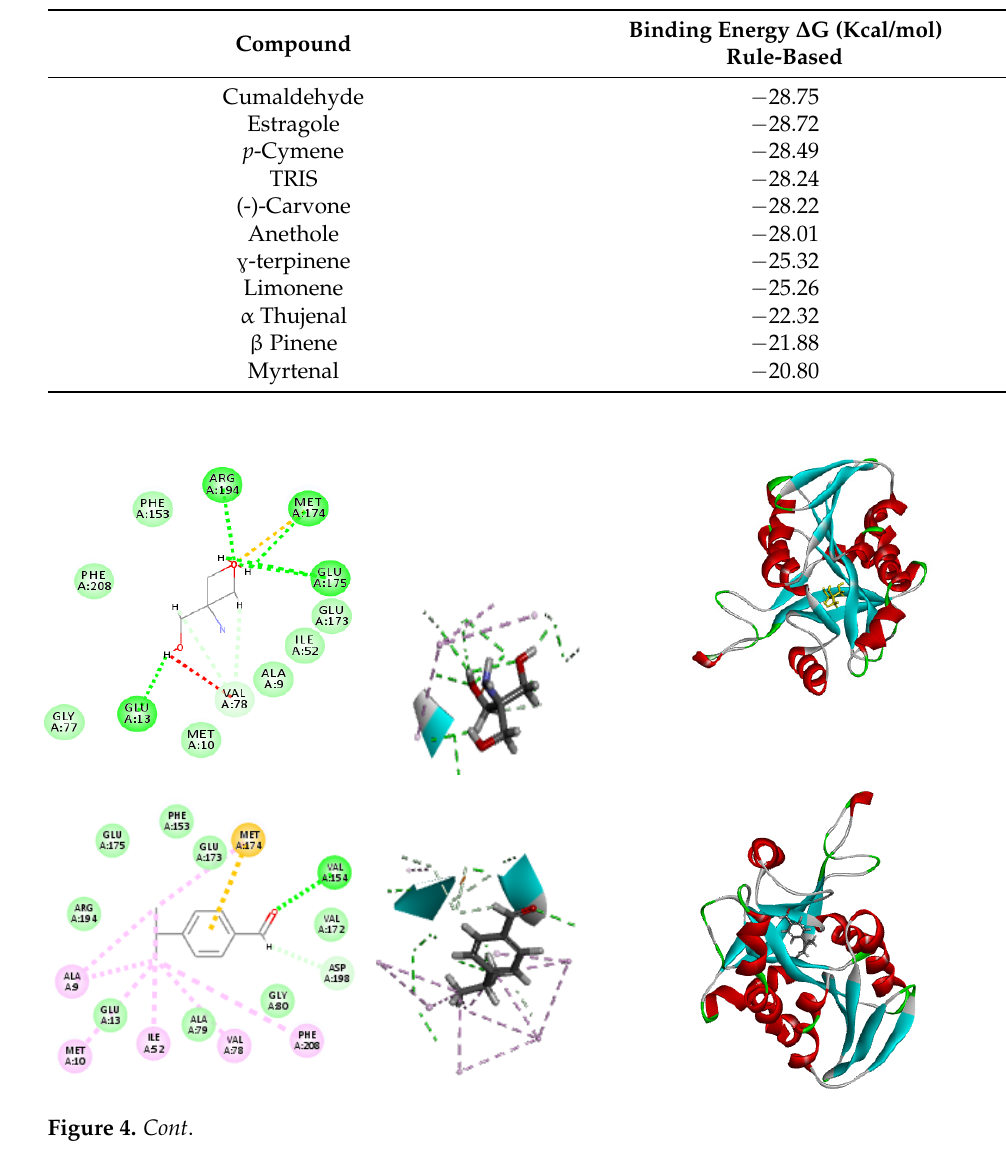
Table 3. Free binding energies ( ∆ G) of the identified compounds within the 3NM4 active site calculated in kcal/mol using Discovery Studio 4.5, adopting both rule-based ionization techniques.